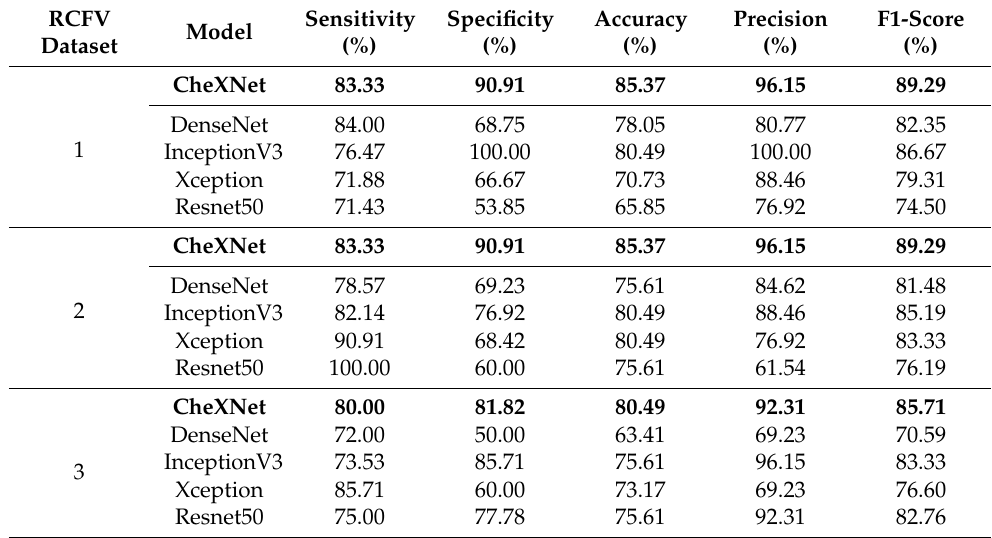
Table 2. The performance is based on the prediction probability of five CNNs models separately on three RCFV datasets.